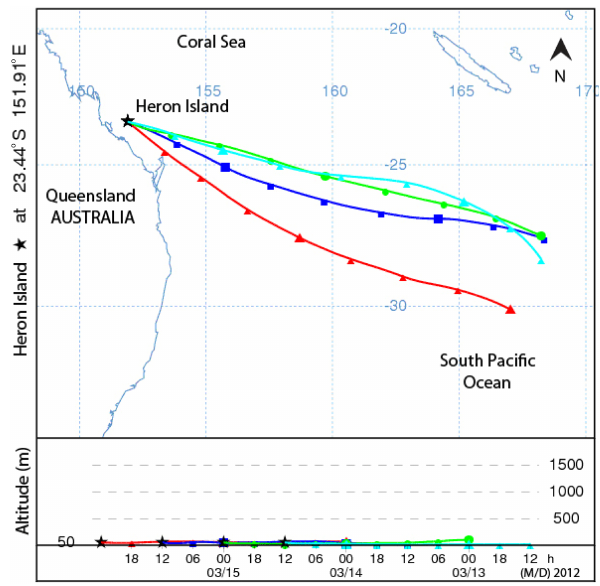
Figure 5. Twelve-hour separated back trajectories of 48h duration ending 16 March 2012 showing the low-level SE marine air flow (red line) that is indicated to have traversed the ∼ 70km length of Capricorn–Bunker Group of coral reefs (Fig. 1b) before arriving at Heron Island. This marine air flow resulted in the longest last- ing DMS a spike and the highest recorded DMS a concentration of 11.5nmolm − 3 during the wet season campaign (Fig.